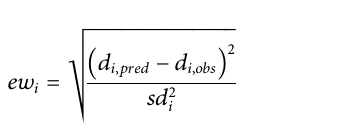
Frontiers in Earth Science |